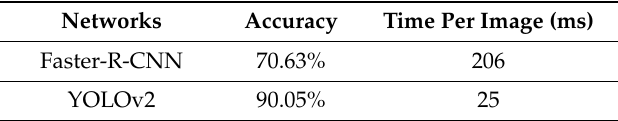
Table 3. Ship Detection Accuracy and Speed Comparison on